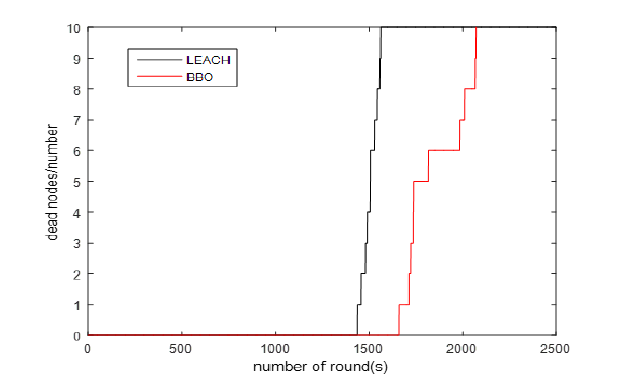
Figure 5. Comparison of dead nodes under two protocols.